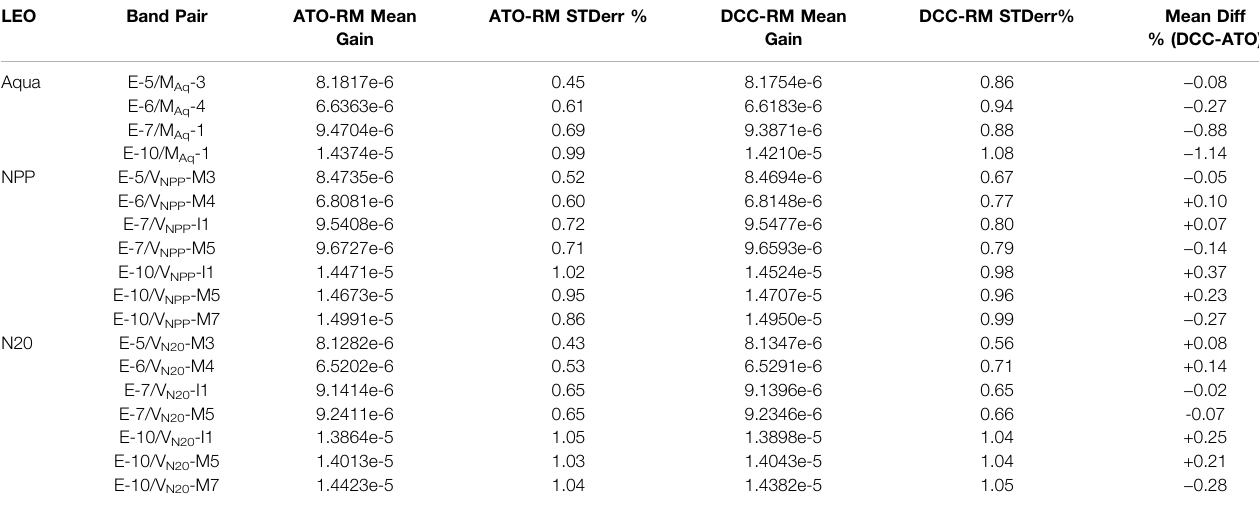
TABLE 3 | EPIC V03 channel ATO-RM and DCC-RM mean gain and trend standard error over the EPIC (2015 – 2021) record with respect to the Aqua, NPP, and N20 band pairings.NotethattheAqua-MODIS,NPP-VIIRS,andN20-VIIRSchannelsareindependentlycalibratedagainsttheirrespectivesolardiffusersandtheresultinggainsare notexpectedtomatchbetweenimagers.TheATO-RMandDCC-RMgaindifferenceisalsogiven.Notethatthetwoindependentray-matchingmethodsprovideverysimilar gain